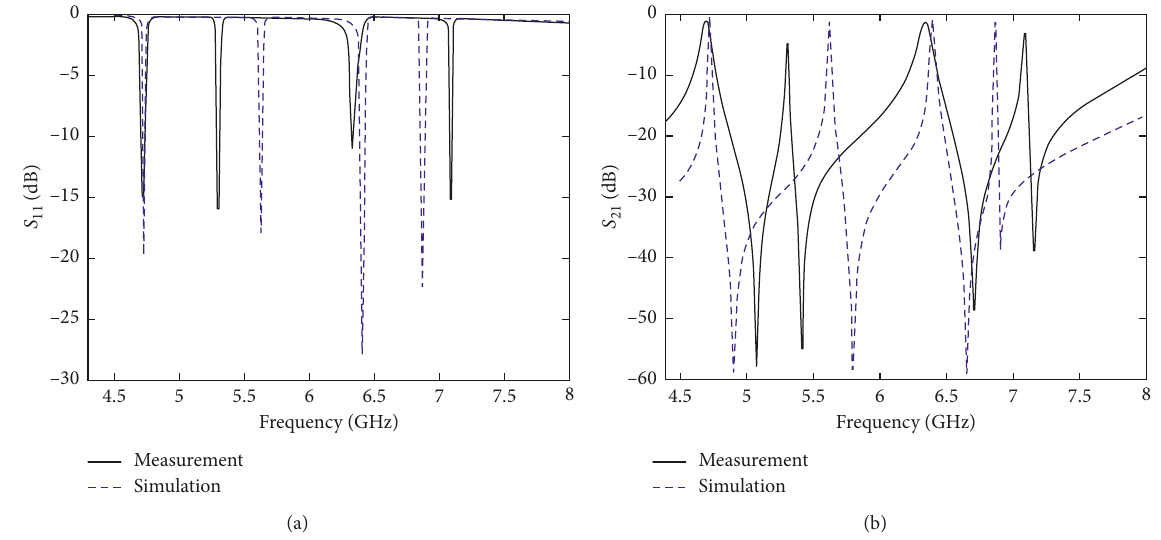
Figure 18: Measured and simulated transmission responses of the proposed quad-band bandpass filter: (a) S parameter [9].